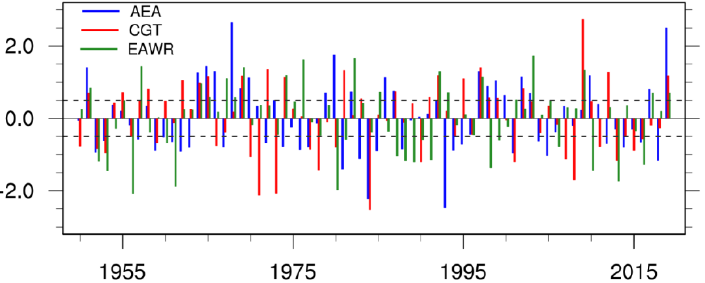
Figure 6. Normalized time series of AEA (blue bars), CGT (red bars) and EAWR (green bars) indices in June from 1950 to 2019.